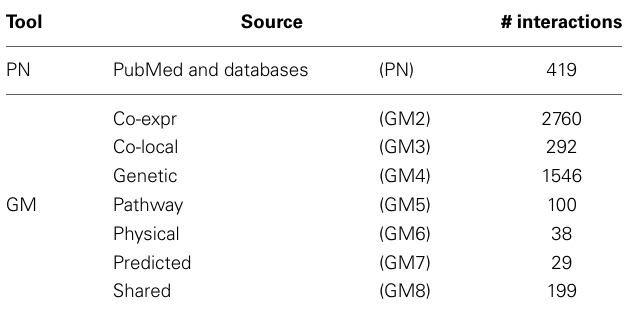
Table 2 | Specifications of prior knowledge retrieval tools: GeneMANIA (GM) and Predictive Networks (PN).